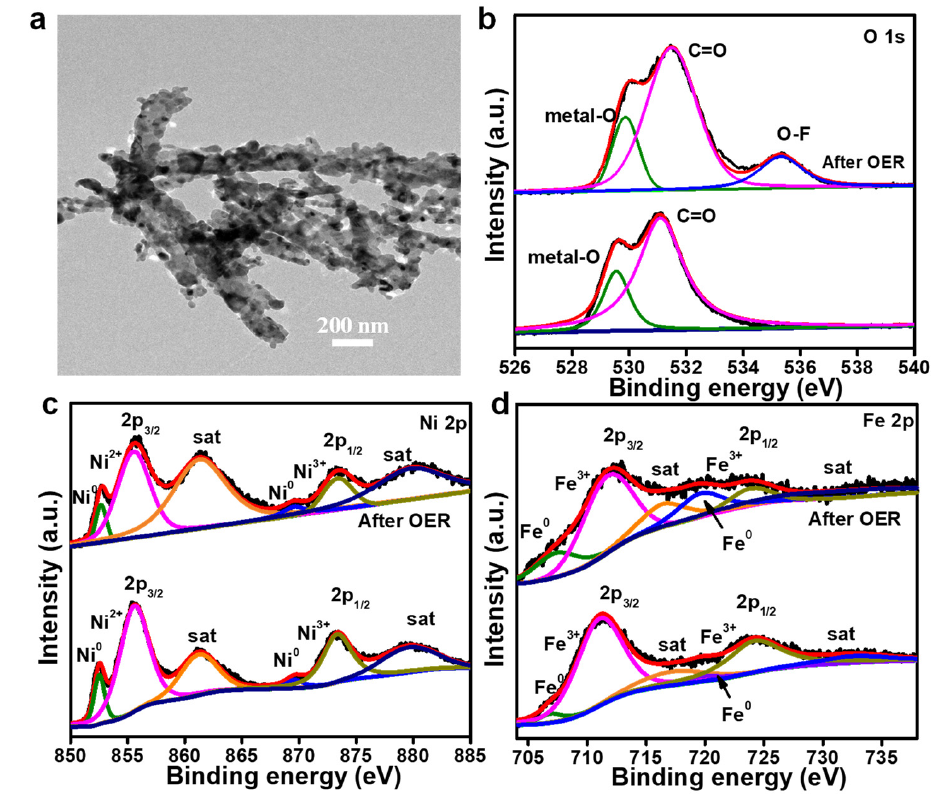
Figure 5. ( a ) TEM image of FeNi 3 /C after the stability test for the OER; ( b – d ) XPS spectrum of O 1s ( b ), Ni 2p ( c ), and Fe 2p ( d ) for the FeNi 3 /C alloy nanorod after the stability test for the OER.